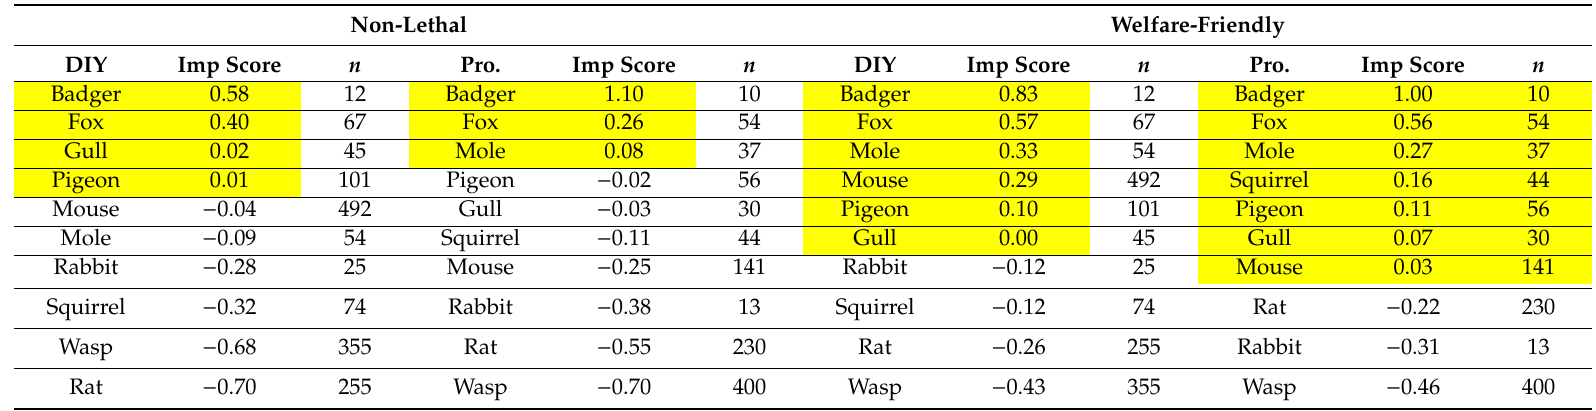
Table 3. Mean importance scores showing the importance in choosing DIY / professional control and of control being non-lethal and welfare-friendly for 10 species. Imp score = Importance score, DIY = Do-It-Yourself control products, Pro. = professional control services. Positive importance scores (shown yellow) indicate that a factor is considered important in choosing control, and greater scores indicate greater importance. Species are ranked in order of decreasing importance of welfare-friendliness or